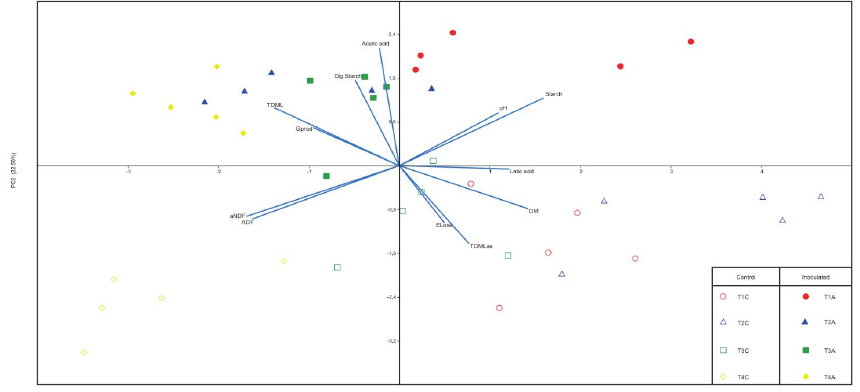
Figure 1. Biplot of principal component analysis (PCA) with respect to the association between chemical and fermentative parameters of silages. T1C : non-inoculated with 30 min delay; T2C : non-inoculated with 90 min delay; T3C : non-inoculated with 150 min delay; T4C : non-inoculated with 210 min delay; T1A : inoculated with 11C33 and with 30 min delay; T2A : inoculated with 11C33 and with 90 min delay; T3A : inoculated with 11C33 and with 150 min delay; T4A : inoculated with 11C33 and with 210 min delay.